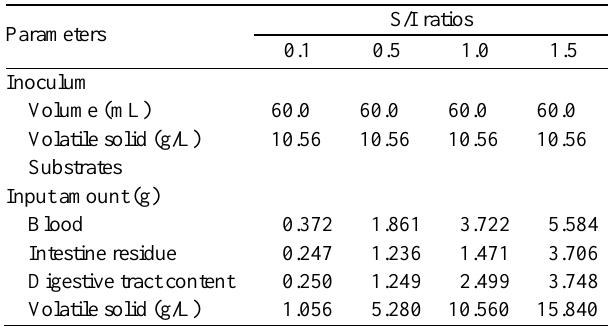
Table 2. Experimental conditions used for the BMP assay at different substrate to inoculum (S/I) ratios